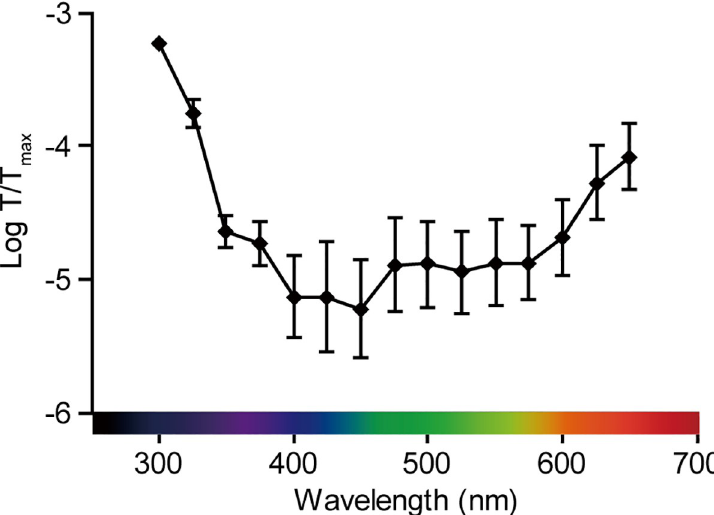
Fig 1. Spectral characteristics of the transmittance of various wavelengths of light reaching the quail hypothalamus. Relative transmittance pattern (T/T max ) of various wavelengths of light penetrating the feathers, skin, skull, and brain tissue are indicated. Each point represents the mean ± SEM (n =